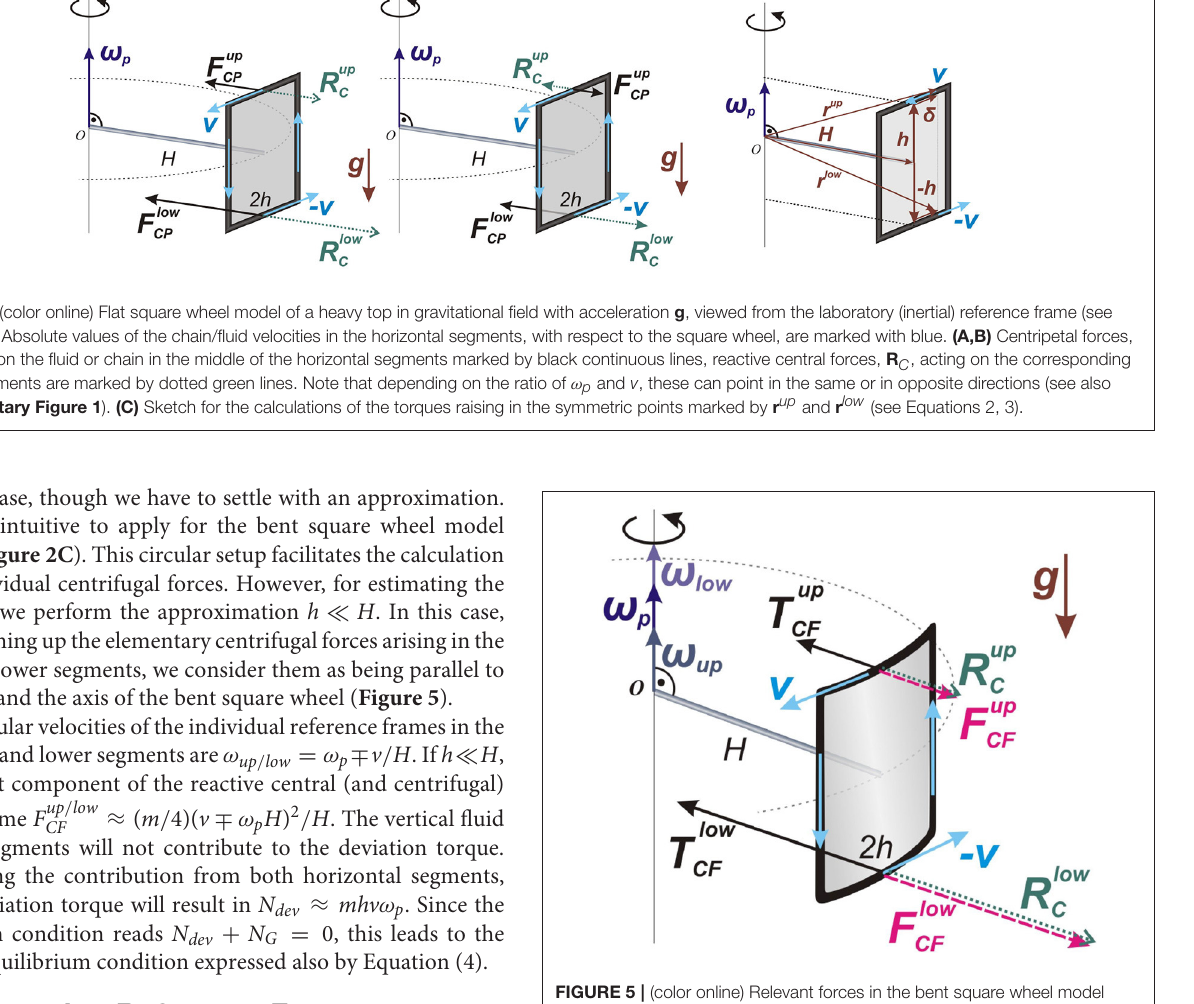
FIGURE 5 | (color online) Relevant forces in the bent square wheel model viewed from the comoving reference frames, that of the chain/fluid elements moving in the upper and lower horizontal square wheel segments (see section 2.5). Notation of forces (see section 2.2 for the nomenclature): F CF , centrifugal force; T CF , central force, both acting on the fluid or chain; R C , reactive central force acting on the support.